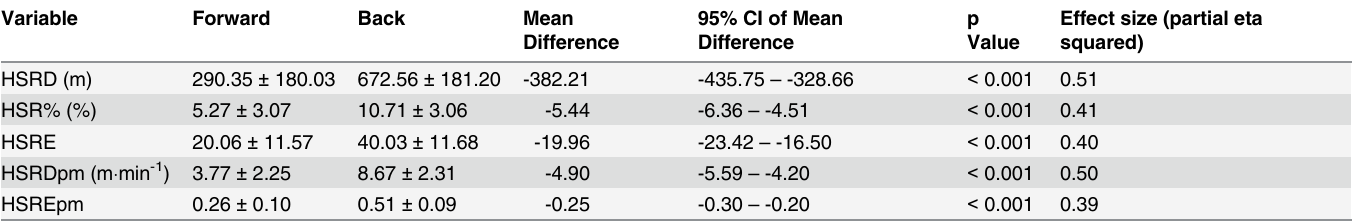
Table 2. Forward vs back ABS HSR